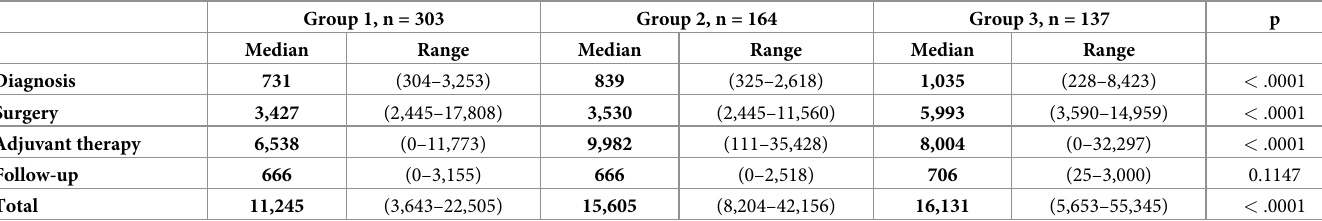
Table 3. Direct medical costs by phase of management and clinical pathway group ( € ), univariate analysis.